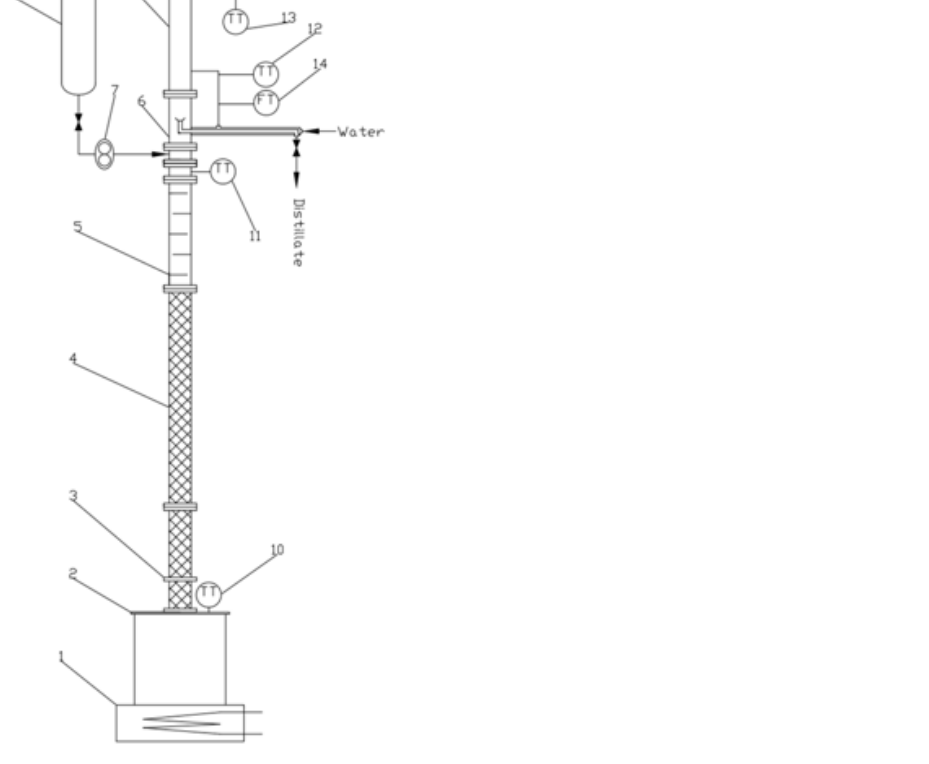
Figure 8. Scheme of the experimental distillation column: 1—electric heater; 2—cube-evaporator; 3—diopter with attachment; 4—unit with a packing; 5—unit with plates; 6—distillate sampling unit; 7—gear pump; 8—condenser; 9—a tank with an extractant; 10—cube temperature sensor; 11—distillate vapor temperature sensor; 12 and 13—cooling water temperature sensors; 14—cooling